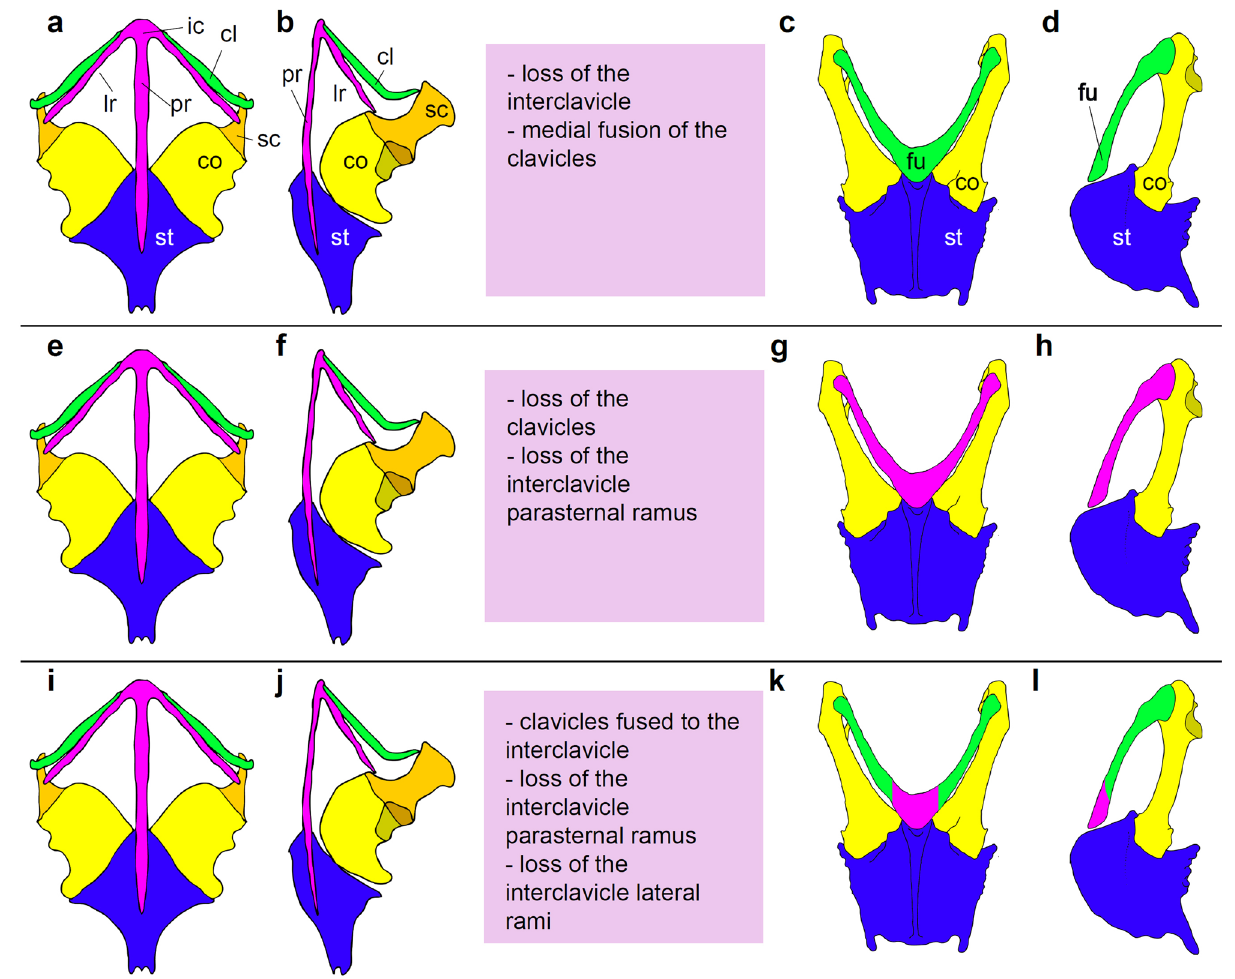
homologous to the clavicles ( a–d ), the interclavicle ( e–h ), or as a compound bone including elements from both the clavicles and the interclavicle ( i–l ). Generalized pectoral apparatus in a non-avian reptile in ventral view ( a , e , i ) and in left anterolateral view ( b , f , j ); in the middle, list of the evolutionary changes inferred along the avian stem lineage following the selected hypothesis; generalized pectoral apparatus in a bird (scapula omitted for clarity) in ventral view ( c , g , k ) and in left lateral view ( d , h , l ). cl clavicle, co coracoid, fu furcula, ic interclavicle, lr lateral ramus of interclavicle, pr parasternal ramus of interclavicle, sc scapula, st sternum. Drawing by